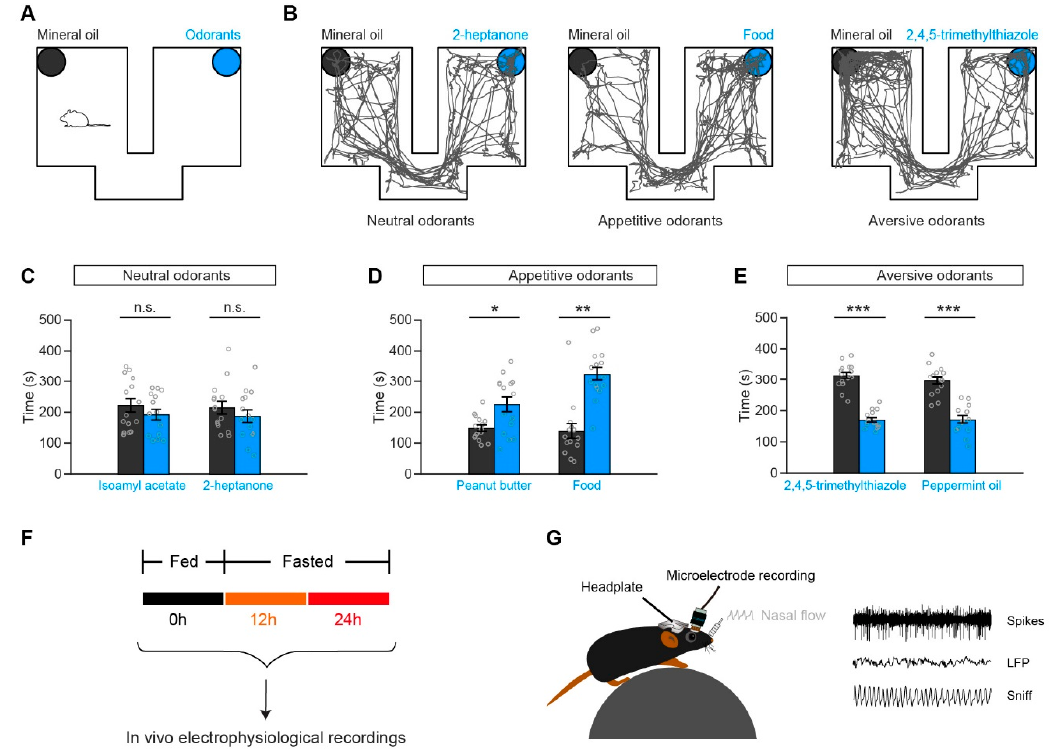
Figure 1. Paradigm for the preference/avoidance test and in vivo recordings. ( A ) Schematic of the preference/avoidance test. ( B ) Representative movement traces illustrating three different behaviors